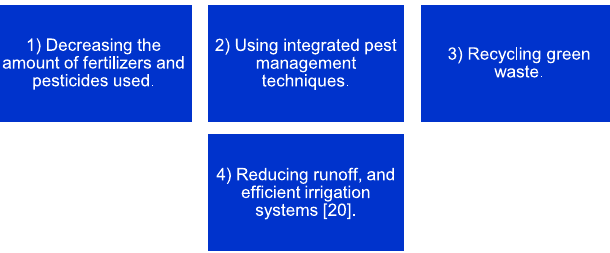
Fig. 12. Sustainable vegetation planting guidelines for mega cities in